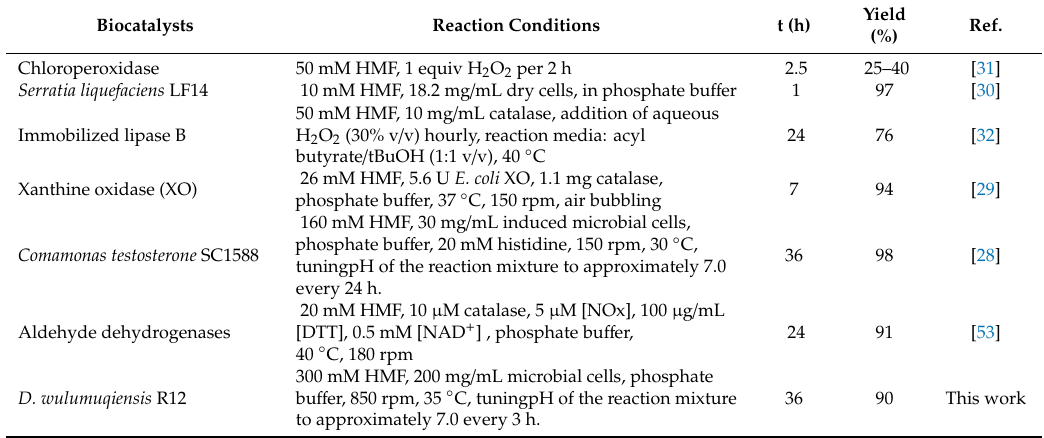
Table 1. HMFCA synthesis via HMF oxidation by various biocatalytic